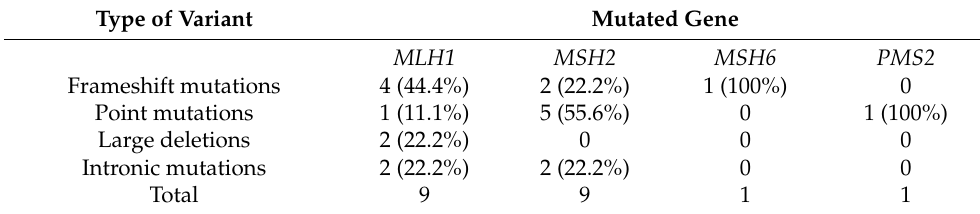
Table 3. Types of variants per MMR gene in Affected individuals.